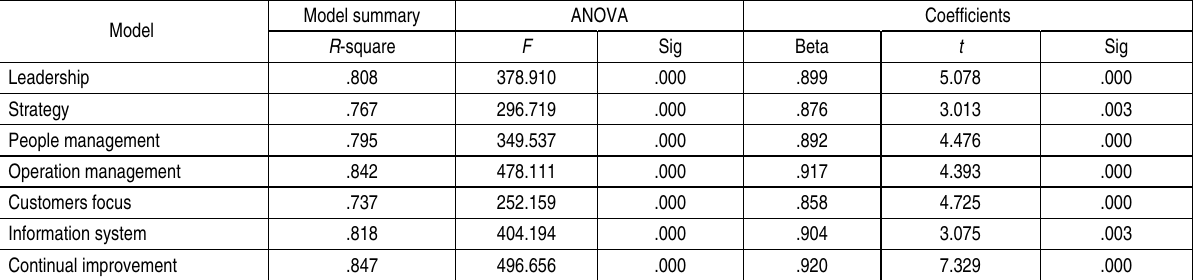
Table 4. Simple Regression Analysis Values